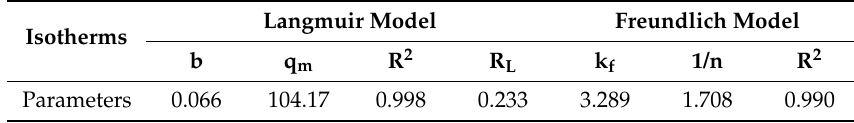
Table 3. Isotherm parameters for MB dye adsorption onto